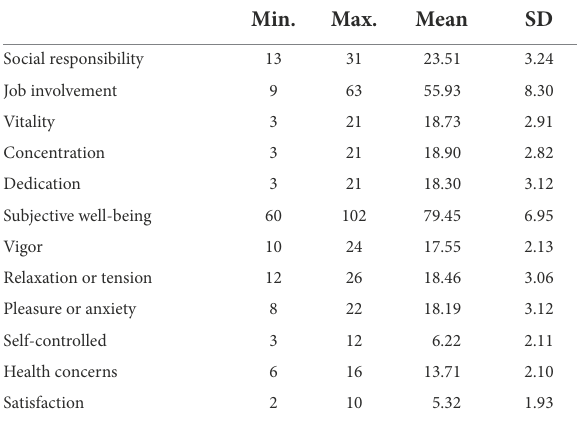
TABLE 1 Social responsibility, job involvement and subjective well- being of